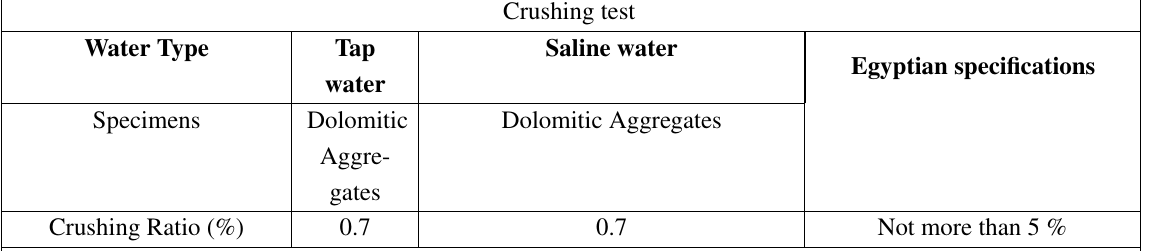
Table 2. Eligibility testing results for aggregate materials regarding base coarse